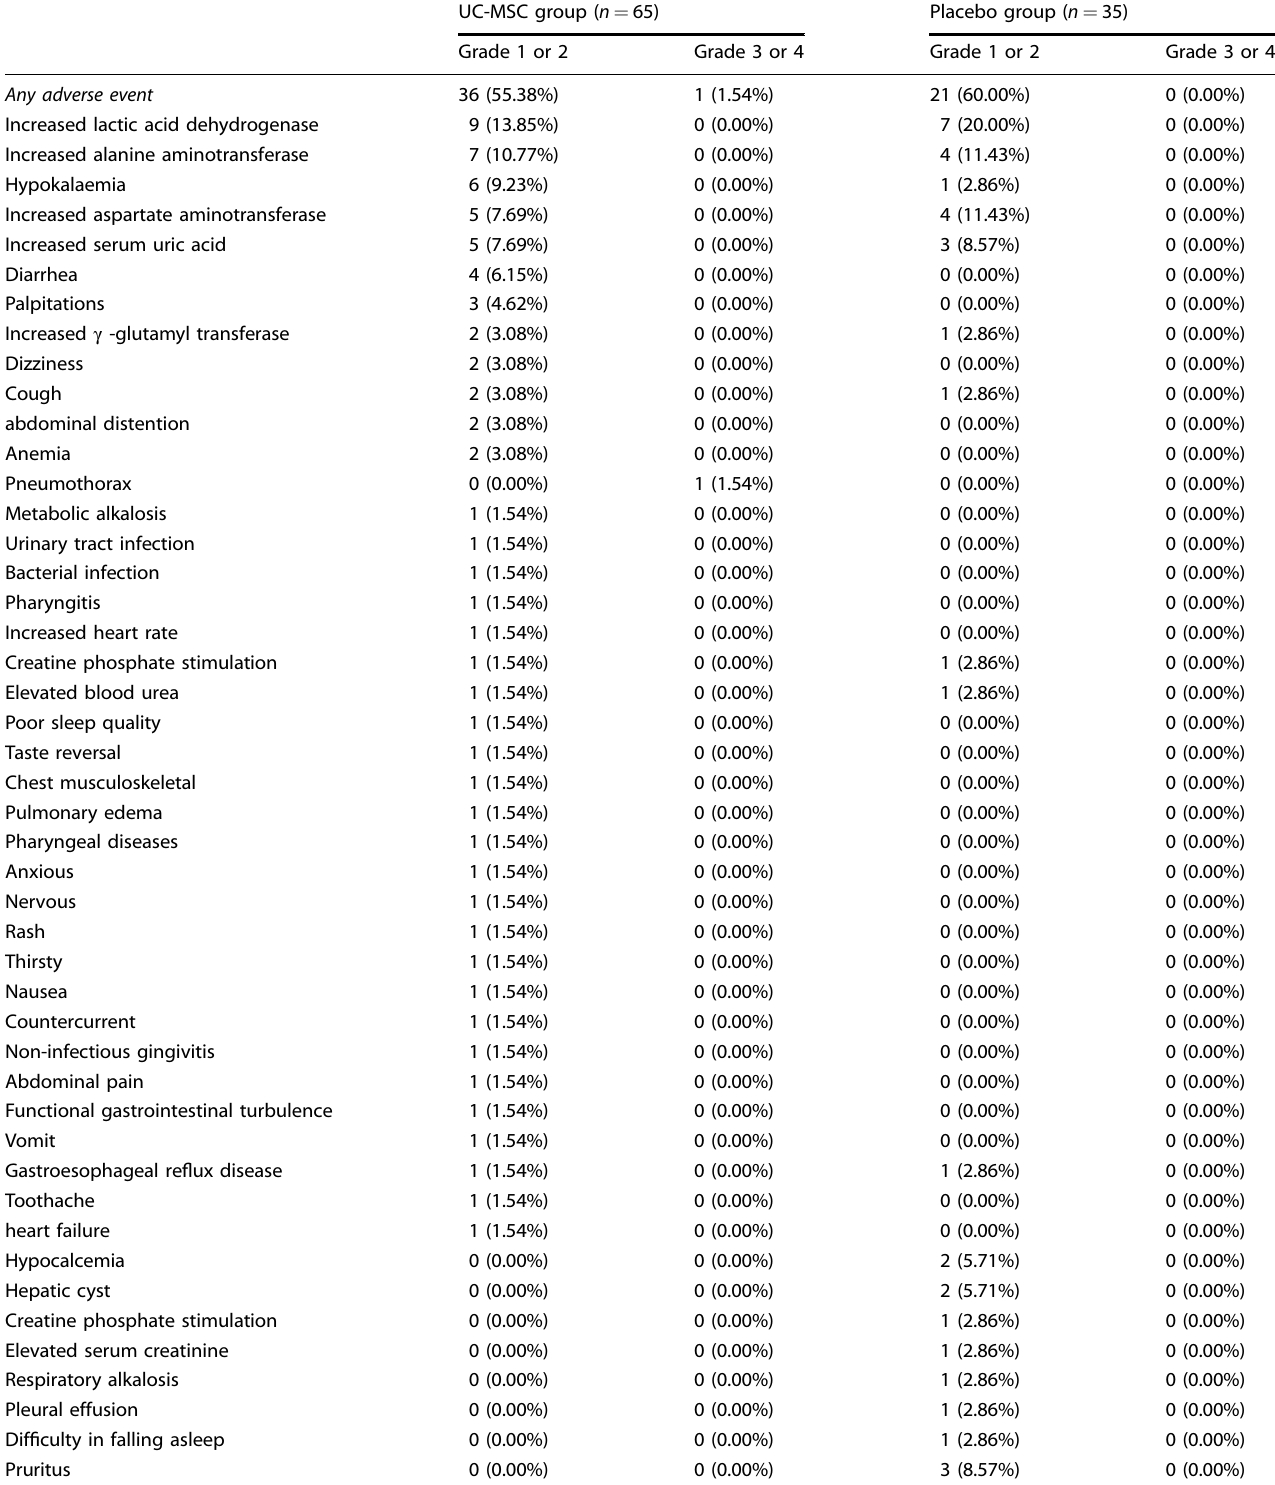
Table 3. Summary of adverse events that occurred in the enrolled population of the